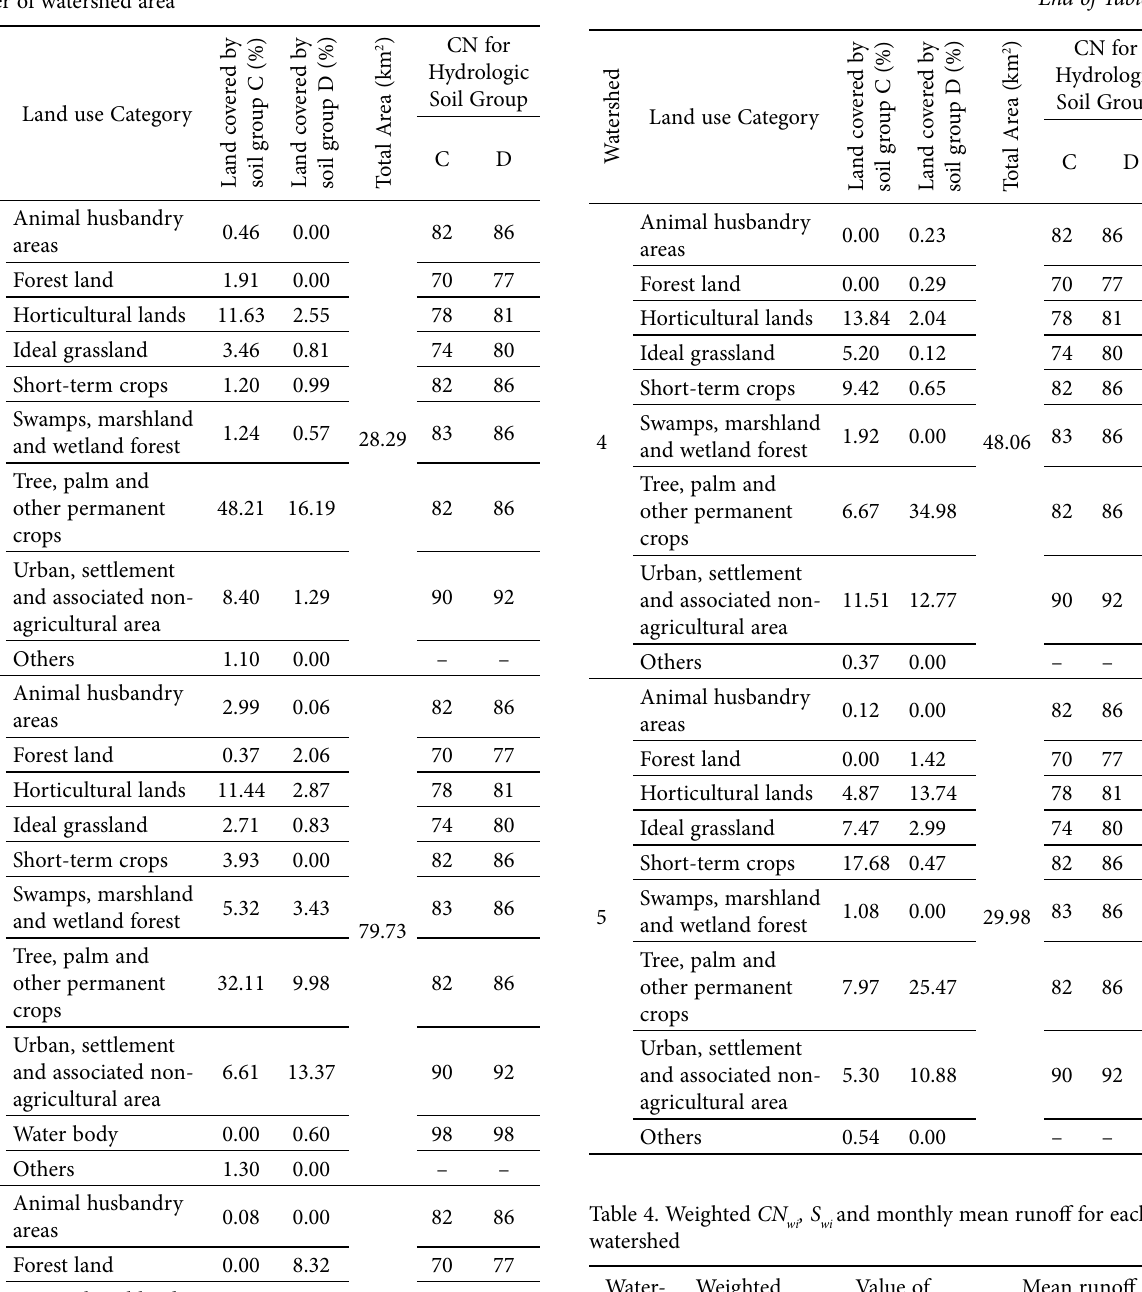
Table 3. CN for particular soil category and percentage of land cover of watershed area